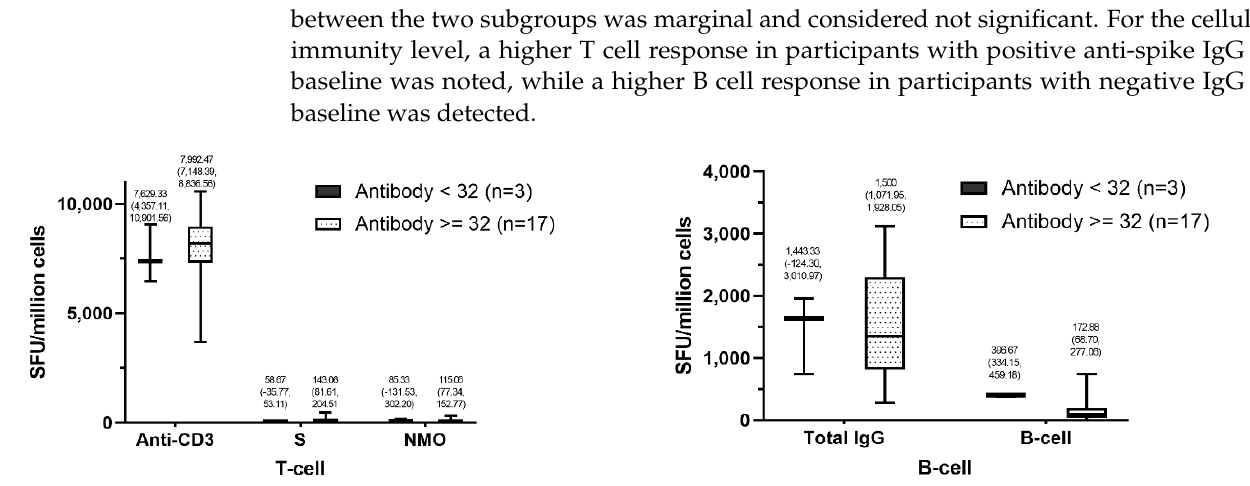
Figure 4. Cellular immunity level in 20 participants after being vaccinated with ChAdOx1 nCoV-19 as the third dose following two doses of CoronaVac based on the baseline anti-spike IgG status. For T cell functions, SARS-CoV-2 S defined peptide pool and SARS-CoV-2 NMO defined peptide pool were used, while ASCs counting with a sandwich assay technique was used for B cell function. T cell and B cell functions reported as SFC per one million cells were measured 3 months post-vaccination. ASCs: antibody-secreting cells; NMO: nucleoprotein, membrane protein, and open reading frame proteins; S: spike protein.